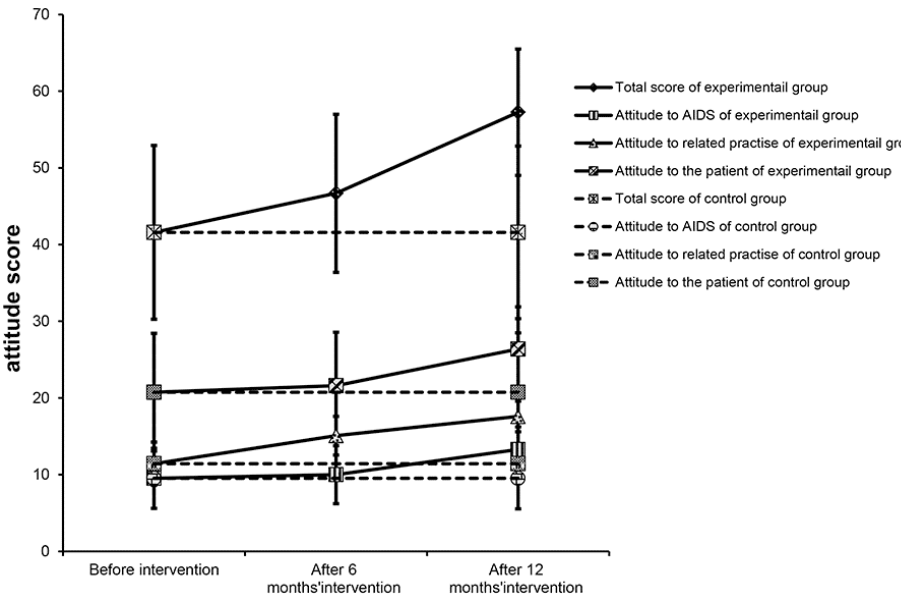
Figure 4. Changes in attitude